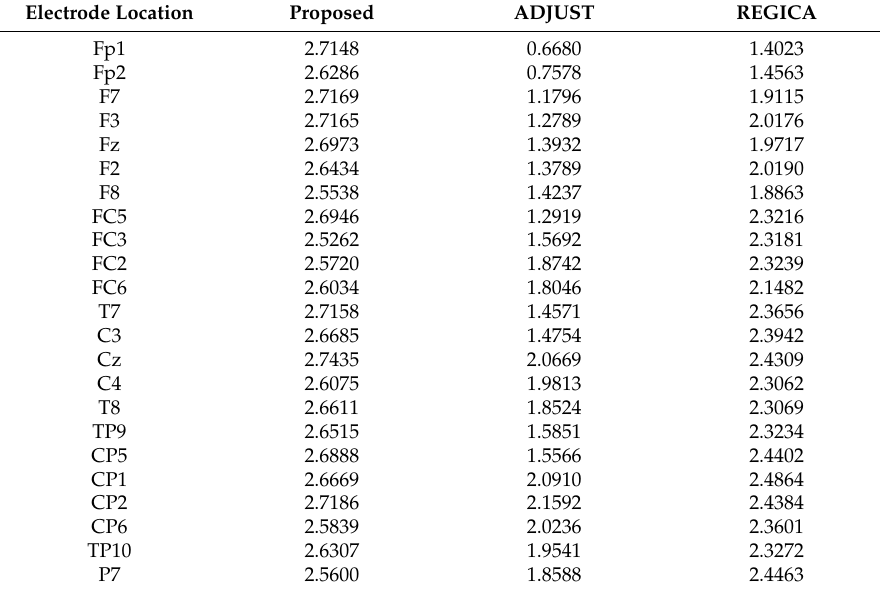
Table 3. Average mutual information values results of all subjects for the proposed algorithm against ADJUST and REGICA for all